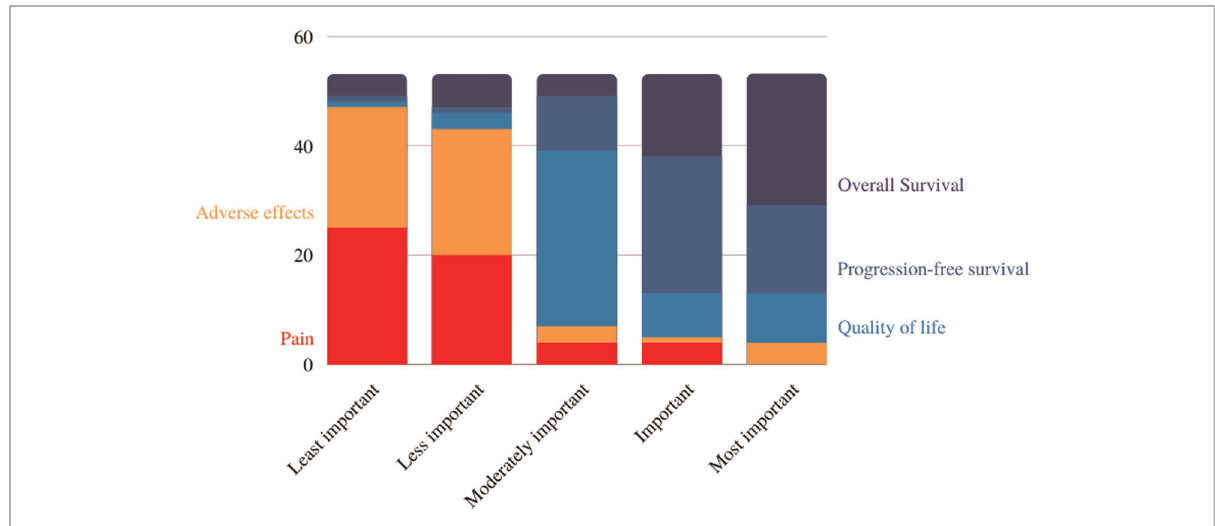
FIGURE 5 Treatment outcome ranking (absolute numbers).